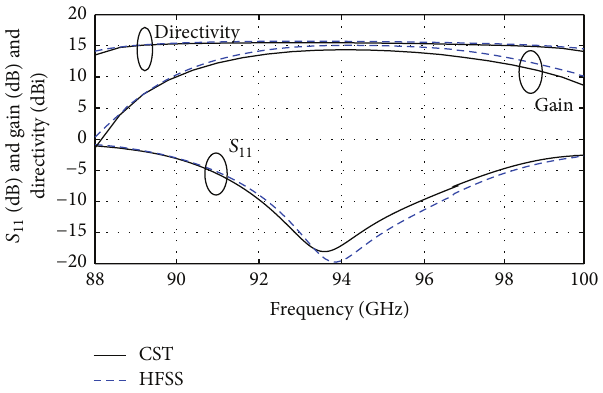
Figure 10: Variation of 𝑆 11 and gain with a superstrate dimension of = 3.125 × 3.125𝜆 0 , and with different heights of ℎ = 0.5𝜆 0 , ℎ = ℎ = 0.6𝜆 0.55𝜆 0 , and 0 .